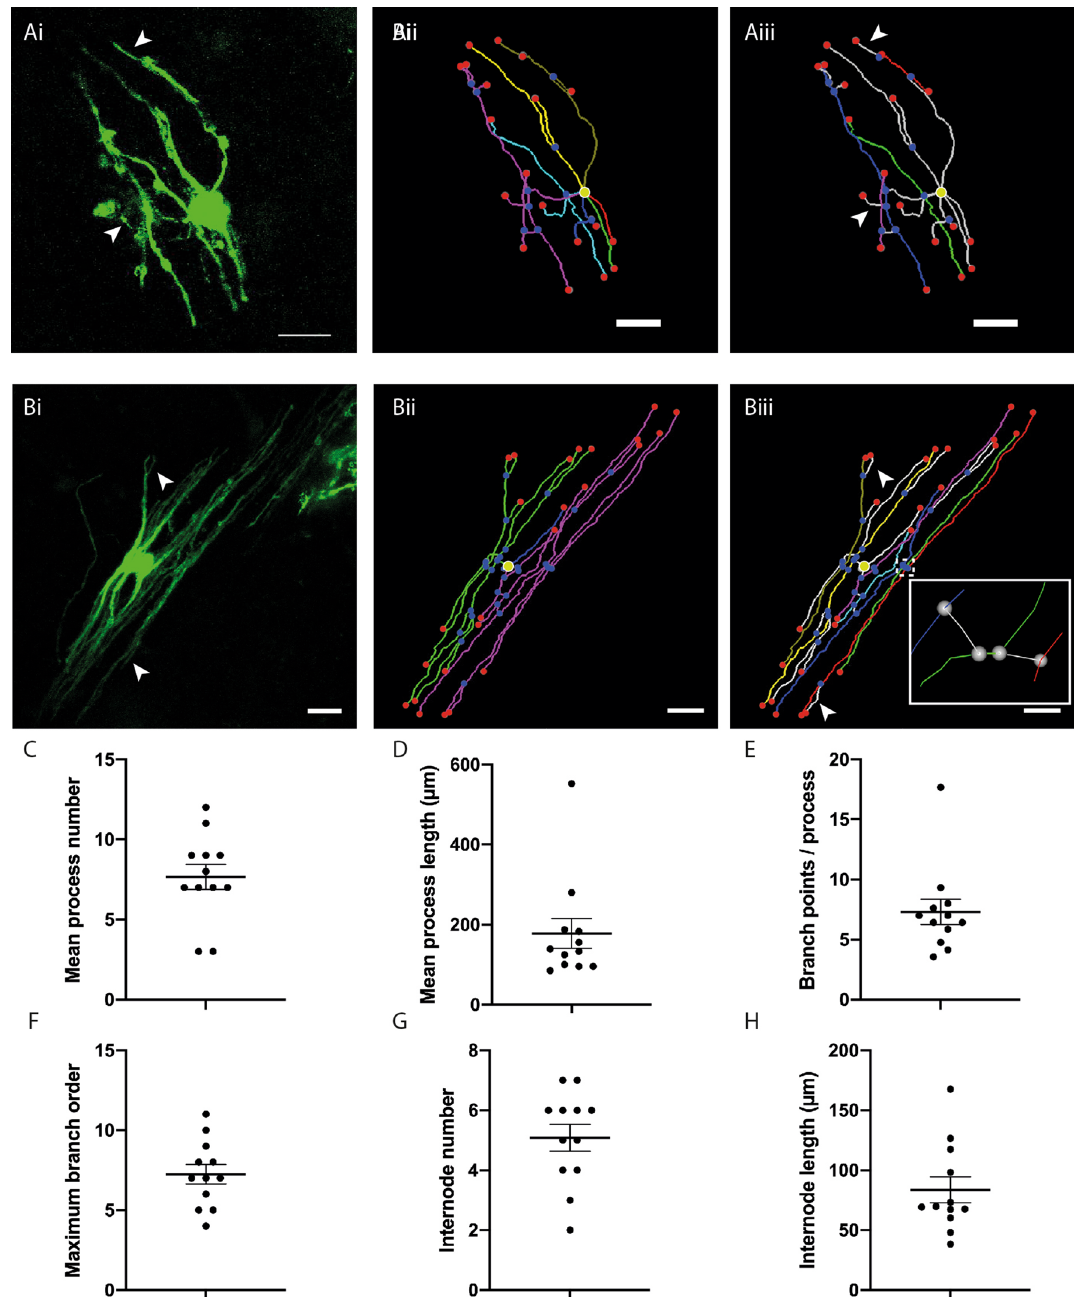
Figure 3. 3-D reconstructions of SFV-labelled OL and quantification of OL process morphology. ( Ai ) Maximum projection showing eGFP-f expression in a relatively simple white matter OL transduced with SFVA7(74). ( Aii ) 3-D reconstruction of the cell shown in ( Ai ). Segment colours (cyan, blue, green, yellow, gold, red, purple) indicate seven individual process arbors. Yellow circle indicates position of cell body. ( Aiii ) Reconstruction of the cell shown in ( Ai ) indicating position of four identified internodes (blue, purple, green, red). ( Bi ) Maximum projection showing eGFP-f expression in a relatively complex OL. ( Bii ) 3-D reconstruction for the cell shown in ( Bi ). Segment colours (blue, green, purple) indicate three individual process arbors. ( Biii ) Reconstruction of the cell shown in Bi indicating seven putative internodes (cyan, blue, green, yellow, gold, purple, red). Individual processes (green and purple in Bii ) support multiple putative internodes. Inset: Expanded view of area indicated by dashed box reveals the initiation of internodes from neighboring internodes via fine connecting processes (white segments). Scale bars in ( A ) and ( B ) 20 µm. ( C – H ) Scatter plots displaying features of OL process morphology: mean process number per OL (7.67 ± 0.78) ( C ), mean process length (178 ± 37.5 µm) ( D ), average branch points per process (7.3 ± 1.05) ( E ), maximum branch order per process (7.25 ± 0.60) ( F ), mean internode number per cell 5.08 ± 0.45 ( G ), and mean internode length (83.7 ± 10.71 µm) ( H ). Arrows in ( Ai )/( Aiii ) and ( Bi )/( Biii ) indicate fine branches stemming from putative internodes. In ( Aii – iii ) and ( Bii – iii ) red and blue spheres indicate segment end-points and junction points respectively. Yellow circles indicate position of cell body. Data expressed as means ±